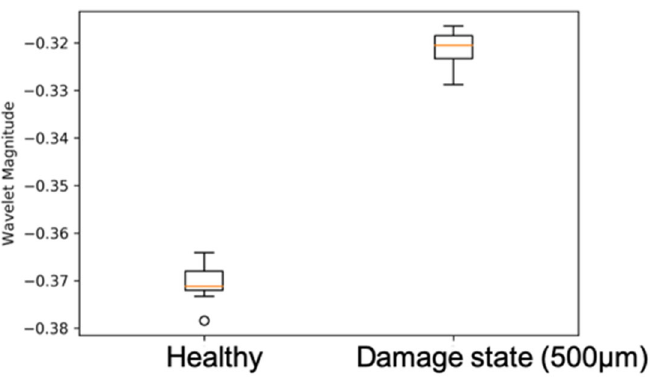
Figure 4. The above box plots are of the de ‐ noised signal, as described in the procedure. The plot on the left is of a healthy PZT sample, and the one on the right is of a PZT ceramic sample with 500 μ m damage size in the 1st damage state.